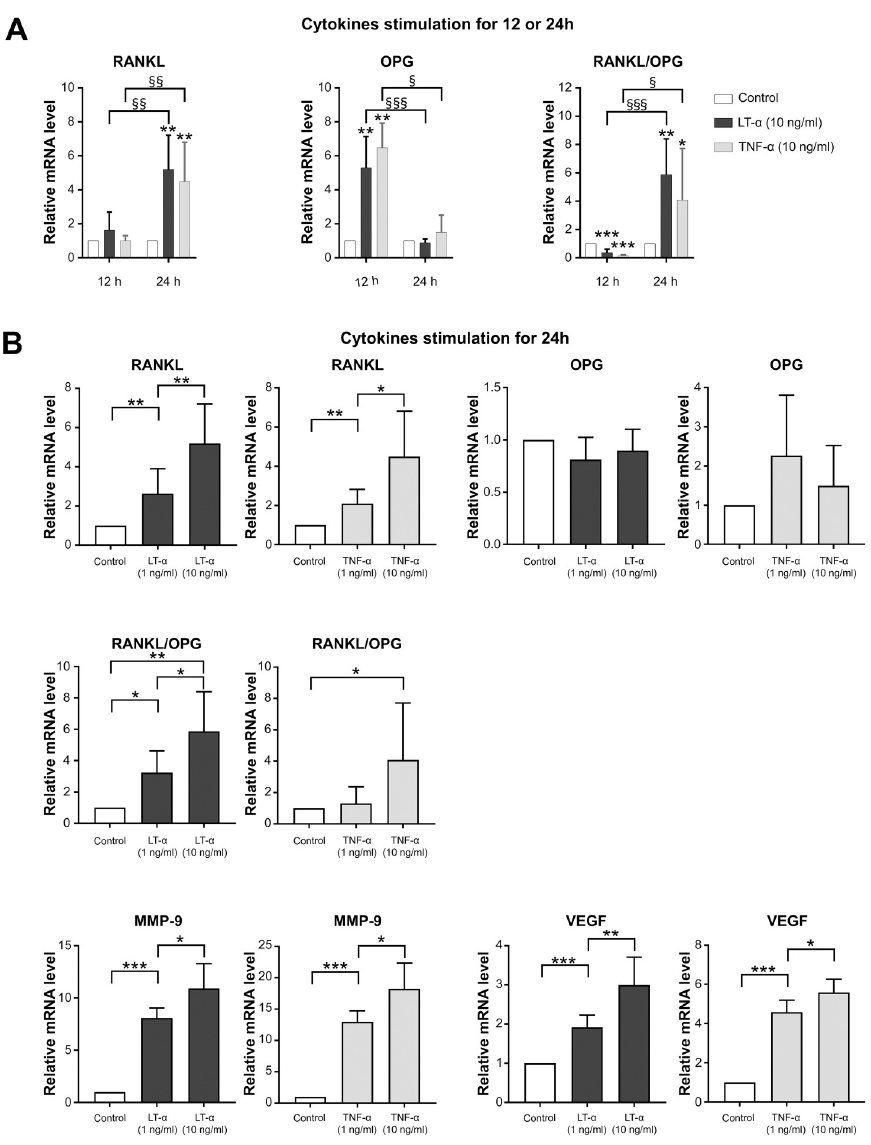
Fig 4. Cytokines induced gene expression in chondrocytes. (A) RANKL expression and the RANKL/OPG ratio were up–regulated after 24 hours of stimulation with LT– α or TNF– α , but not after 12 hours of stimulation. (B) RANKL expression and angiogenic factors were up–regulated in a concentration–dependent manner after 24 hours of cytokine stimulation (n = 6 per experimental group). � / § p < 0.05, �� / §§ p < 0.01, ��� / §§§ p < 0.001.